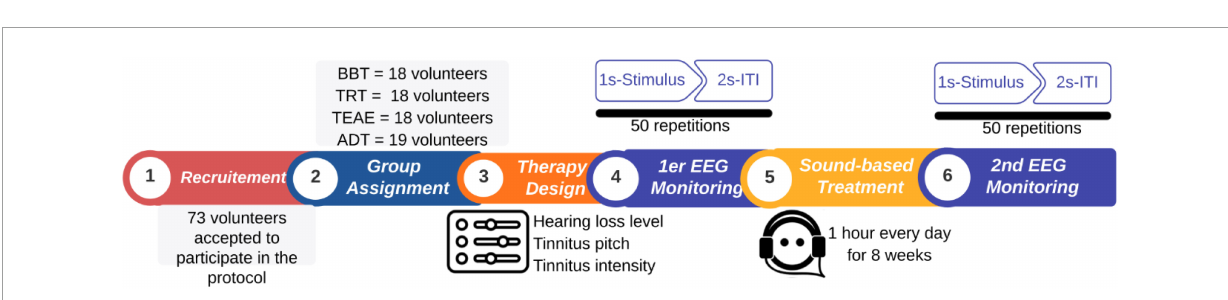
(e.g., line noise, patient motion) and internal (e.g., cardiac,